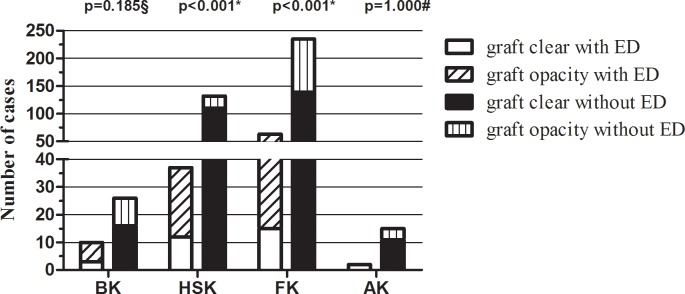
Comparison of graft clarity after penetrating keratoplasty among different etiologies of infectious keratitis in patients with and without epithelial defects during the follow-up period.*Chi-squared test. §Chi-squared test with continuity correction. #Fisher’s exact test.